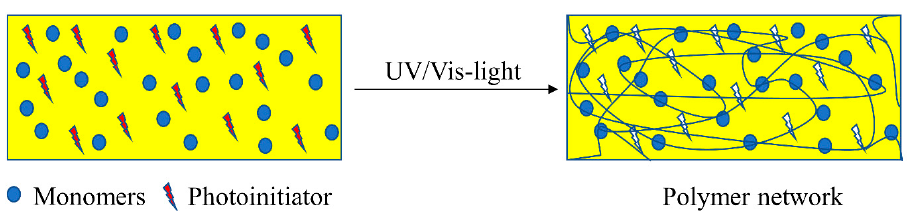
Figure 12. Schematic representation of a photo-curable resin prior to and after light exposure, high- lighting the formation of an insoluble and infusible polymer network.